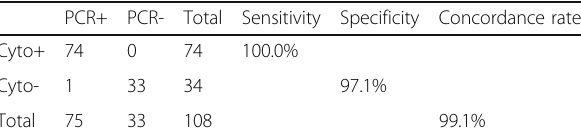
Table 5 Concordance rates determined between cytogenetic analysis and multi-fusion gene F-qRT-PCR screening in 108 AML patients